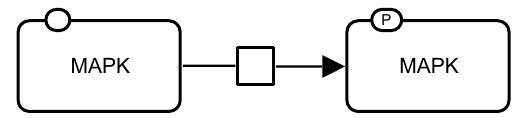
Figure 2.23: Phosphorylation of the protein MAP kinase.